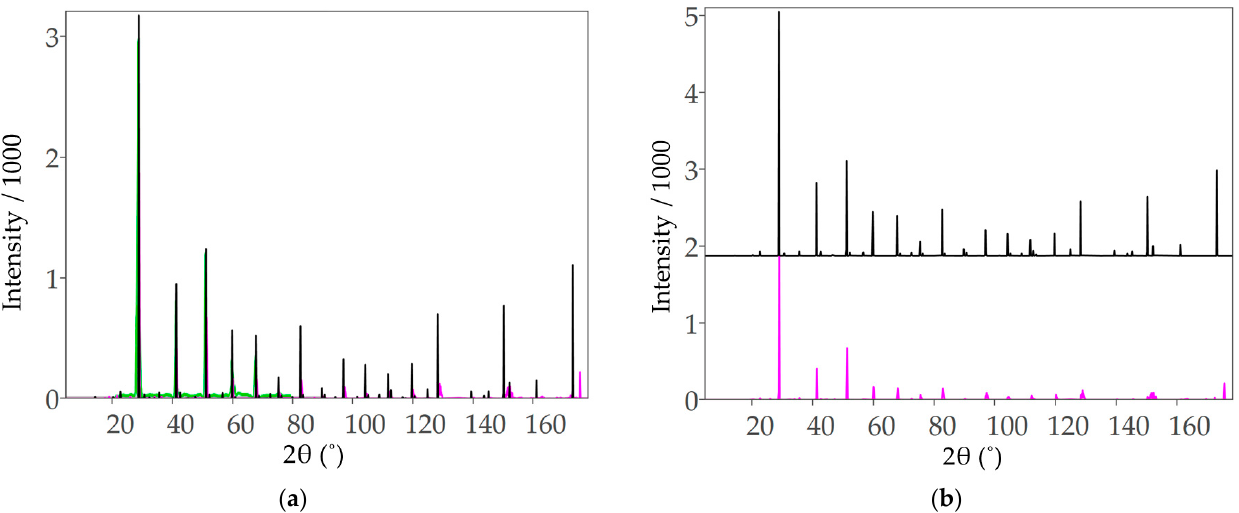
Figure 1. ( a ) Simulated X-ray diffraction patterns for orthorhombic (pink) and cubic (black) BCF8515 for 2 θ from 0° to 180°, overlayed with data extracted from Zhu et al . [13] (green). ( b ) Simulated X-ray diffraction patterns for orthorhombic and cubic BCF8515 for 2 θ from 0° to 180°, stacked. Simulated data generated using CrystalDiffract ® , CrystalMaker Software Ltd. (Oxford, UK), (www.crystalmaker.com accessed on 26 December 2022).